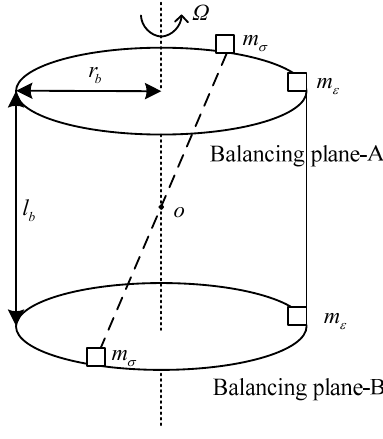
Figure 9. The schematic diagram of the double-plane balancing